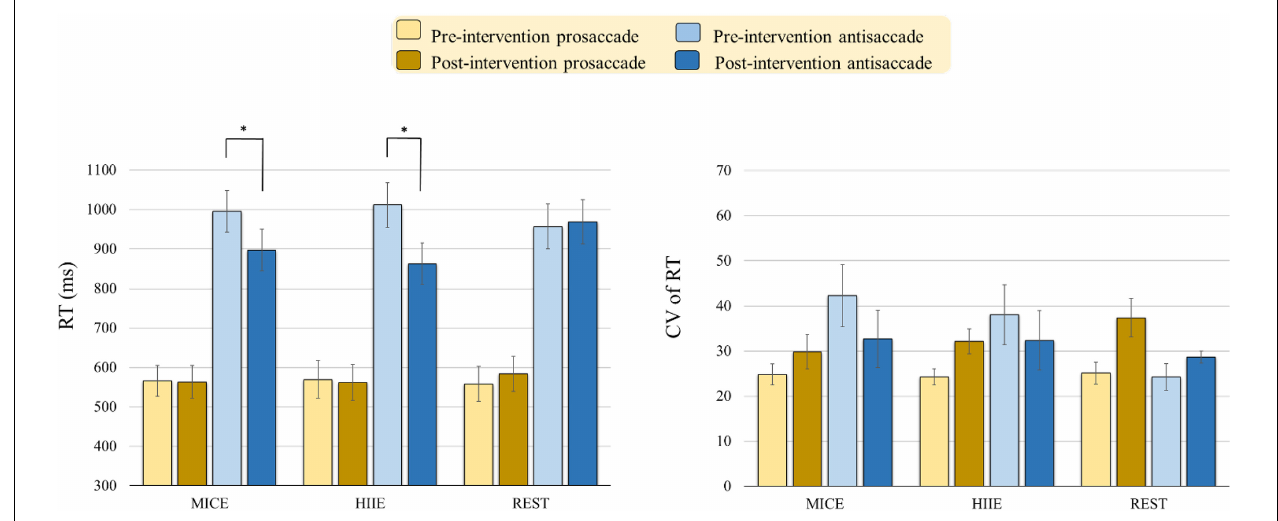
FIGURE 2 | Behavioral performance [i.e., Reaction time (RT) and Coefficient of variation (CV) of RT] (mean ± SE) in the prosaccadic and antisaccadic tasks for the moderate intensity continuous exercise (MICE) and high-intensity interval exercise (HIIE) modes before and after a single bout of exercise, and one non-exercise-intervention (REST) before and after resting (* p <